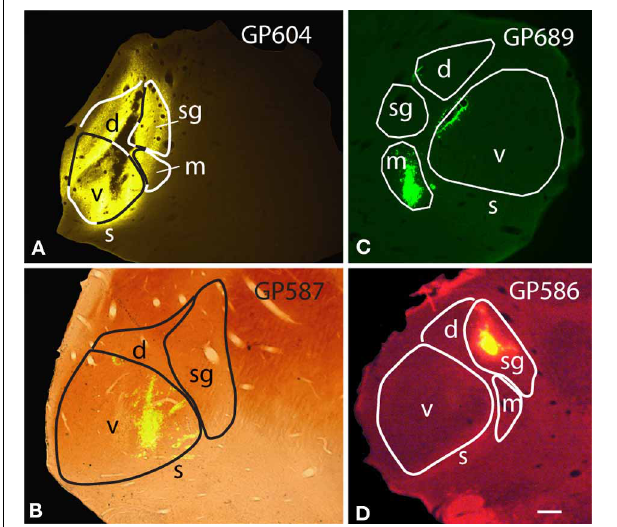
FIGURE 1 | Photomicrographs of representative injection sites in the medial geniculate nucleus (MG). (A) Large injection of FluoroGold that involved all MG subdivisions. (B) Small injection of green beads confined to the ventral subdivision of the MG and visualized in a section that was stained for cytochrome oxidase activity (combined fluorescence and brightfield image). (C) Small injection of green beads confined to the medial subdivision of MG (m). Additional green fluorescence is seen around the margins of a blood vessel along the dorsomedial border of the ventral MG (v); this represents spread of beads that does not result in retrogradely labeled cells. (D) Small injection of red beads into the suprageniculate MG (sg). Scale bar in (D) = 0.5mm and applies to (A–D) . Transverse sections; dorsal is up; lateral is to the left in (A,B,D) , and to the right in (C) . Panels (A,B,D) were originally published in Schofield et al.